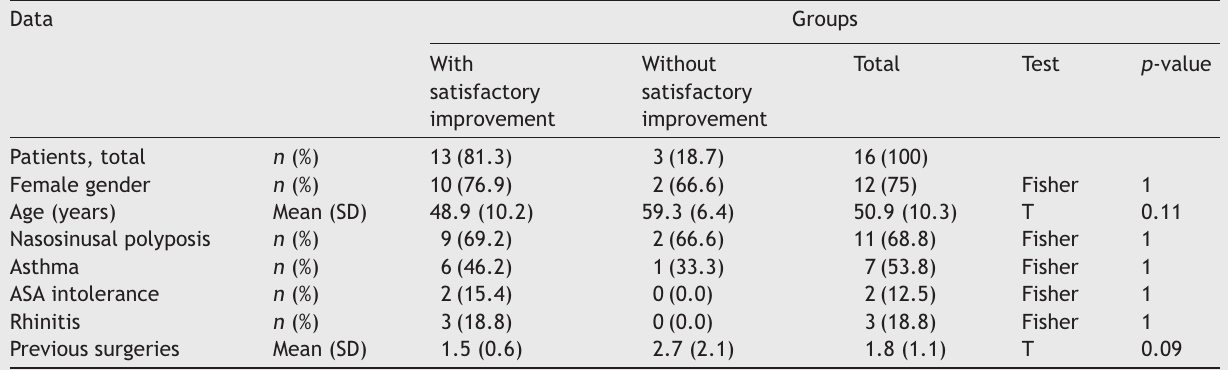
Epidemiological characteristics and subjective outcomes.